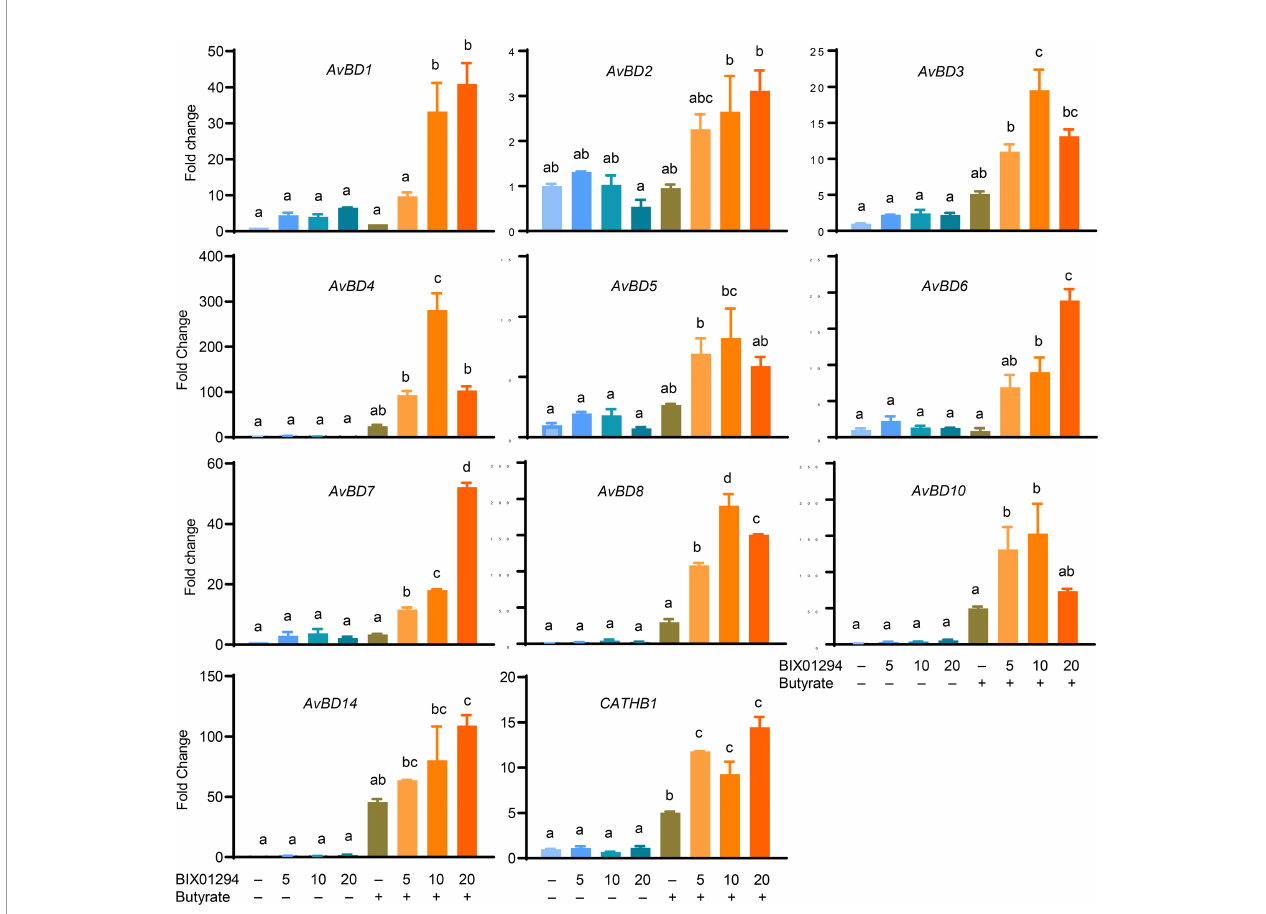
FIGURE 5 | Synergistic induction of multiple HDP mRNA expression in HTC cells between BIX01294 and butyrate. Chicken HTC cells were stimulated in duplicate with indicated concentrations ( m M) of BIX01294 with or without 2 mM butyrate for 24 h, followed by RT-qPCR analysis of different chicken HDP genes. Results are shown as means ± SEM of two independent experiments. The treatments not sharing a common superscript are considered signi fi cantly different ( P < 0.05) based on one-way analysis of variance and post hoc Tukey ’ s